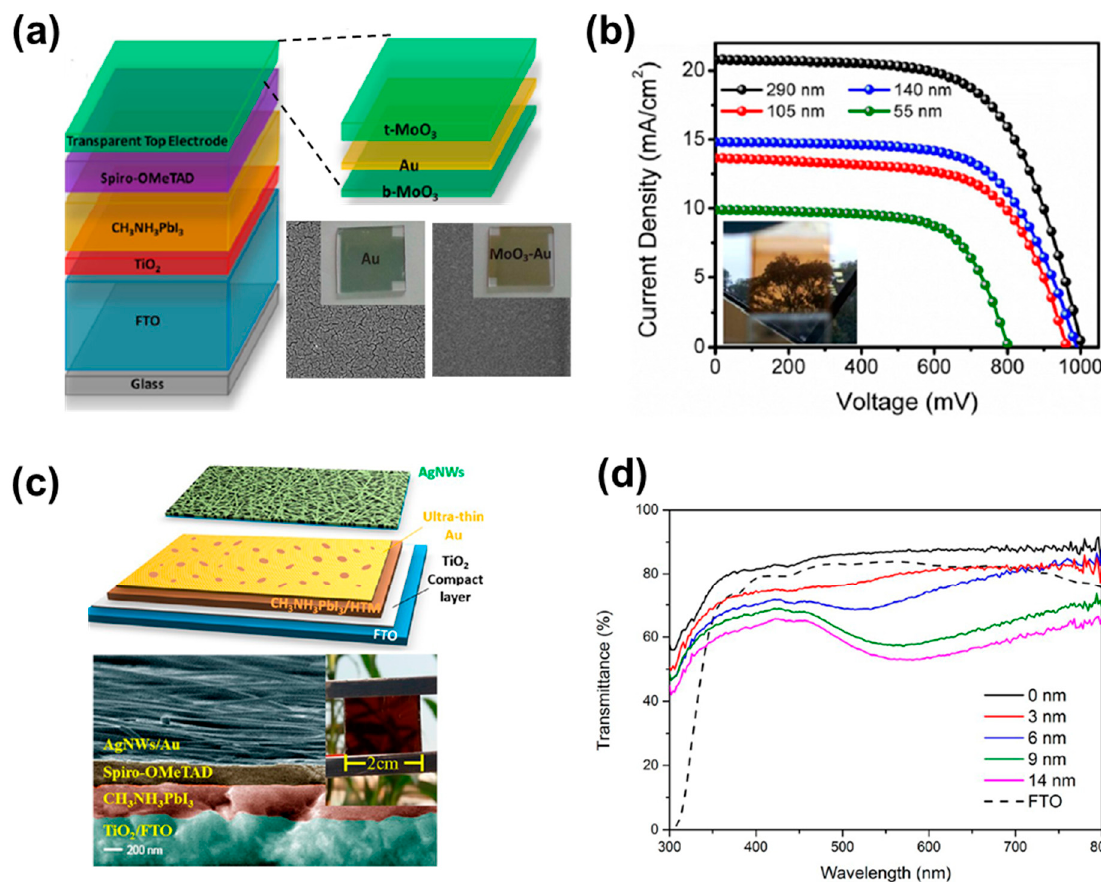
Figure 3. ( a ) Schematic representation of used PSC architecture. Enlarged view of the used top-electrode. SEM image of the used Au film, and of the modified electrode with MoO 3 /Au films. ( b ) Current–voltage characteristics of the fabricated cell with different transparencies. ( c ) Schematic image of devices fabricated with AgNWs composite electrode and ultra-thin Au layer (UTA). ( d ) Transmittance spectra of fabricated devices with different thicknesses. Reprinted with permission from Refs. [30,81].